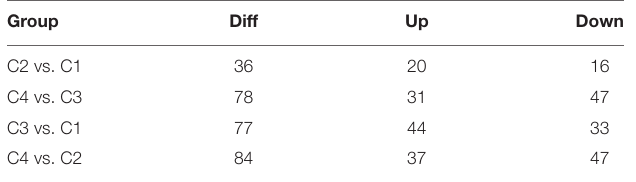
TABLE 3 | Statistical table of predicted new miRNA and comparison of miRNA of each sample.